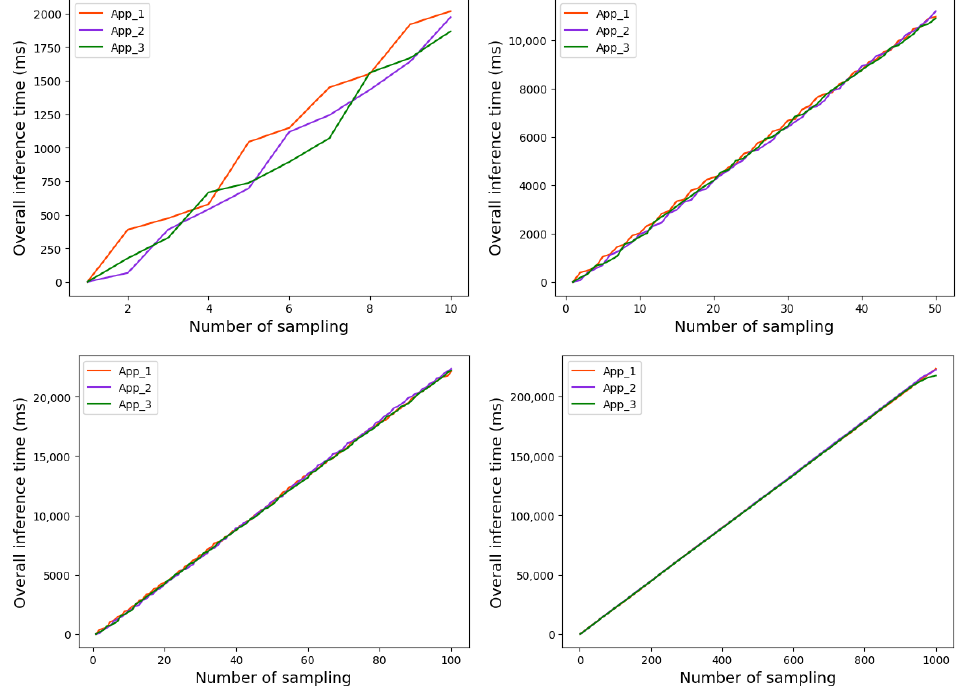
Figure 10. Overall running time of each App based on strategy 1.